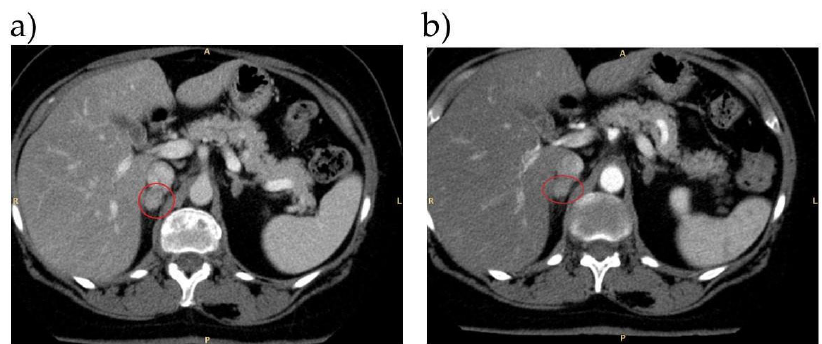
Figure 2. Arterial CT (panel ( a )) and venous (panel ( b ))